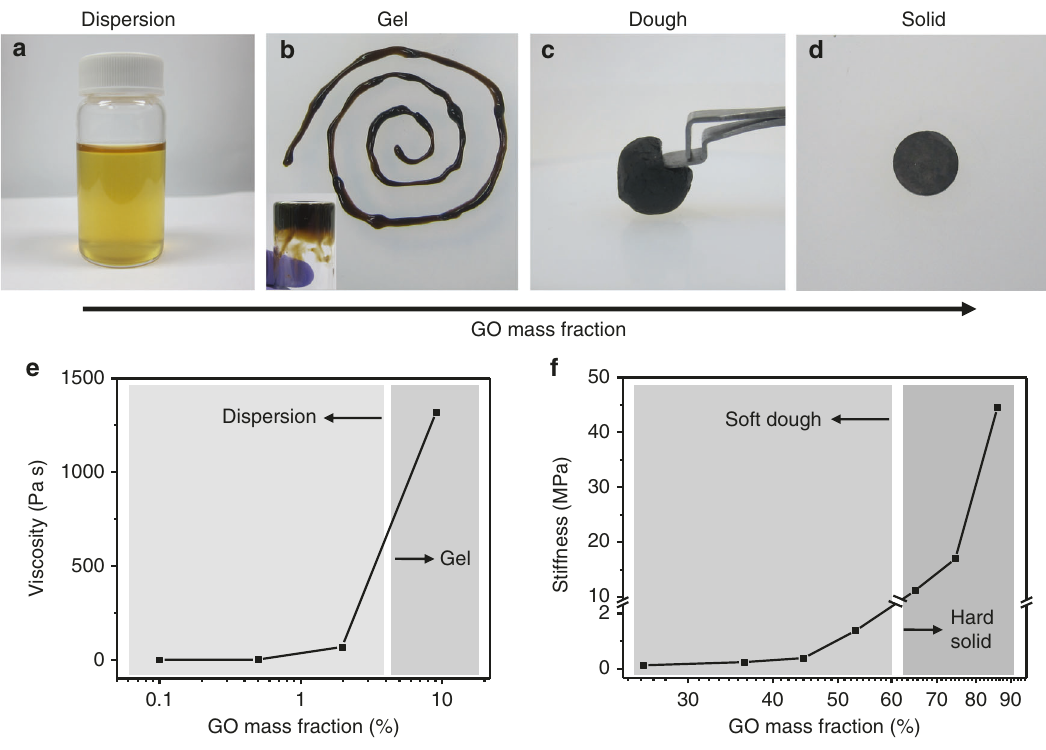
Fig. 1 The GO – water continuum. Photos showing GO – water mixture transitioning from a a dilute dispersion, b a thick gel, c a malleable dough, to d a dense solid, as GO loading increases. e The transition from a dilute dispersion to a gel is characterized by a drastic increase in viscosity. f A dough-state GO is obtained when the mass fraction of GO exceeds 20 wt. %. GO dough is highly malleable until its mass fraction is increased to over 60 wt. %, after